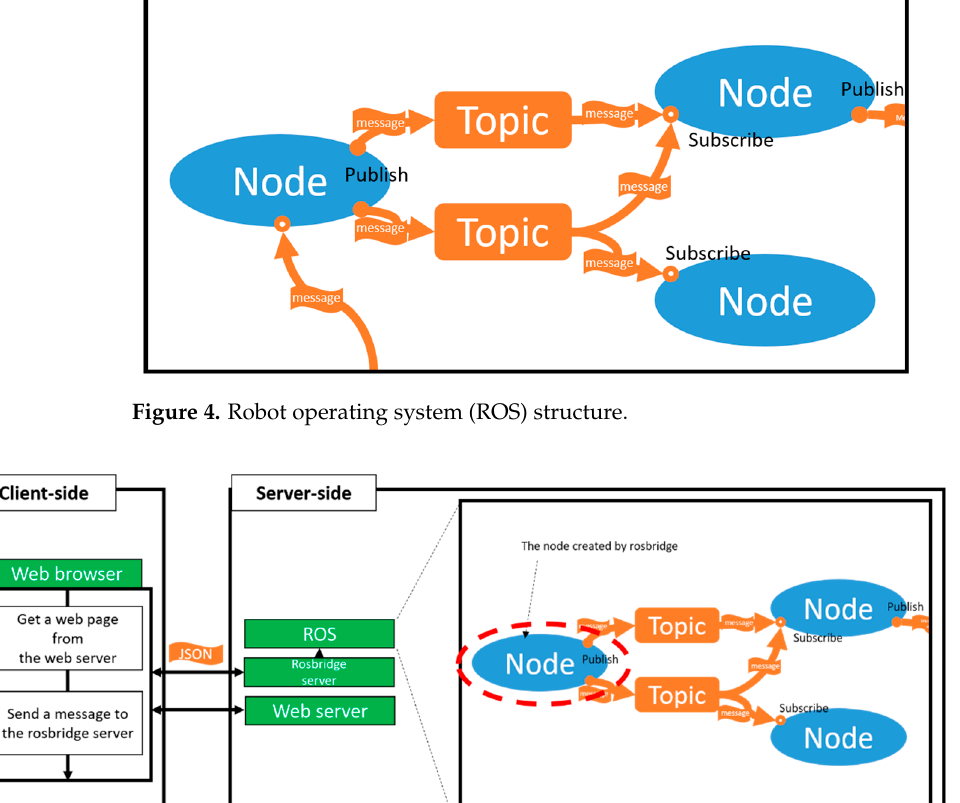
Figure 4. Robot operating system (ROS) structure.